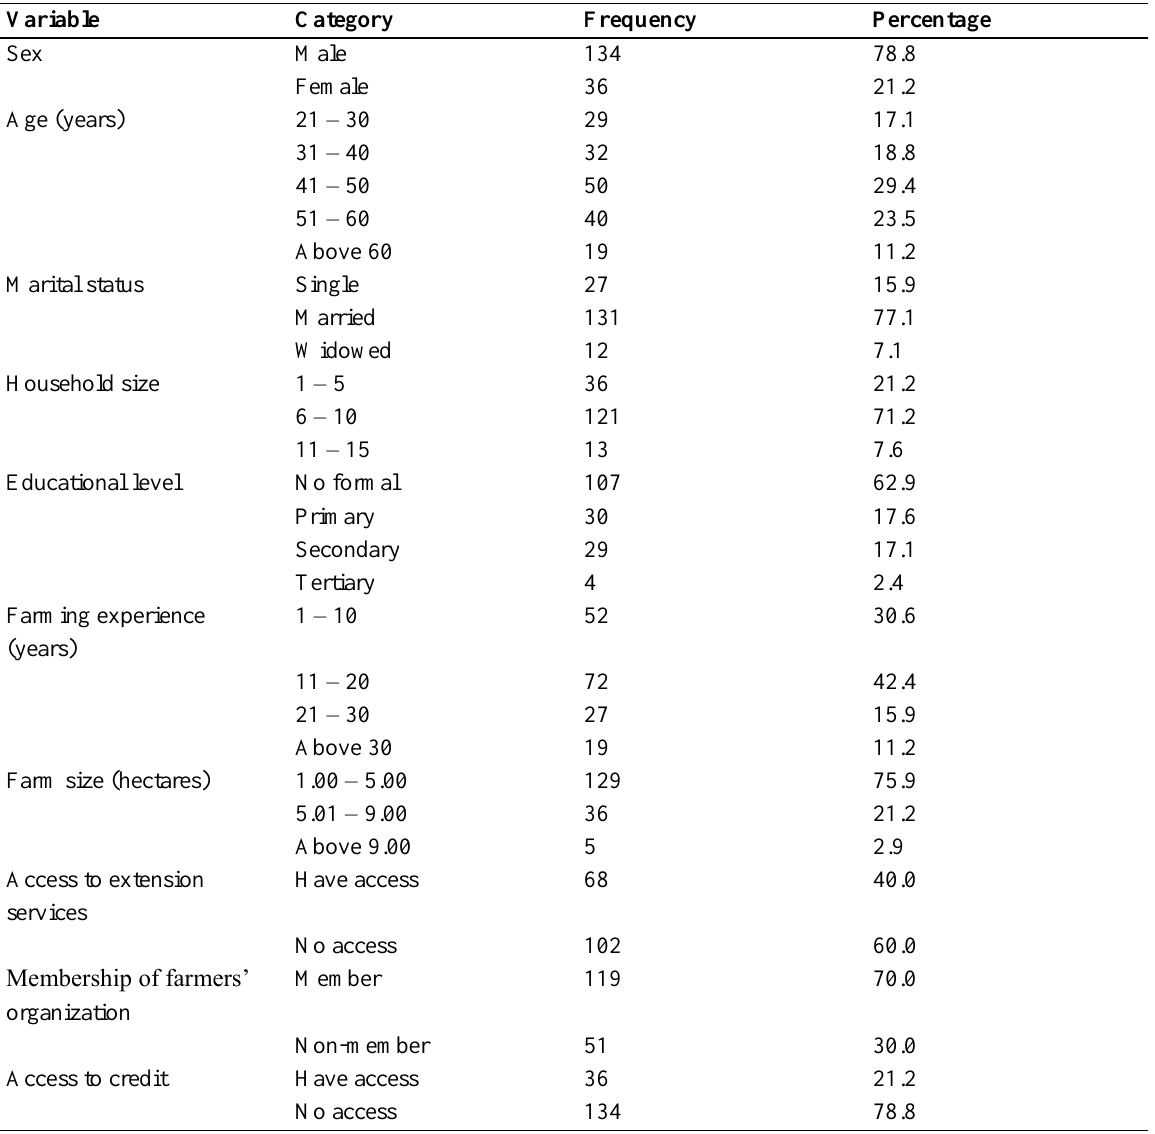
Table 1: Socio-economic characteristics of the respondents (N =